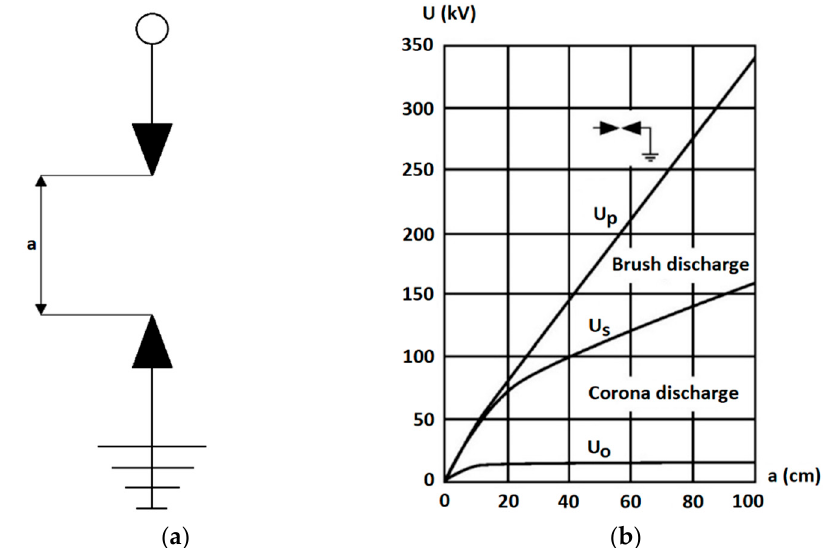
Figure 5. View of a blade-type insulation system: ( a ) Blade with insulation distance A and ( b ) dependence of voltage U o , U s , and U p on the distance between the electrodes for the blade system, where U o —initial voltage, U s —shearing voltage, and U p —jump voltage.